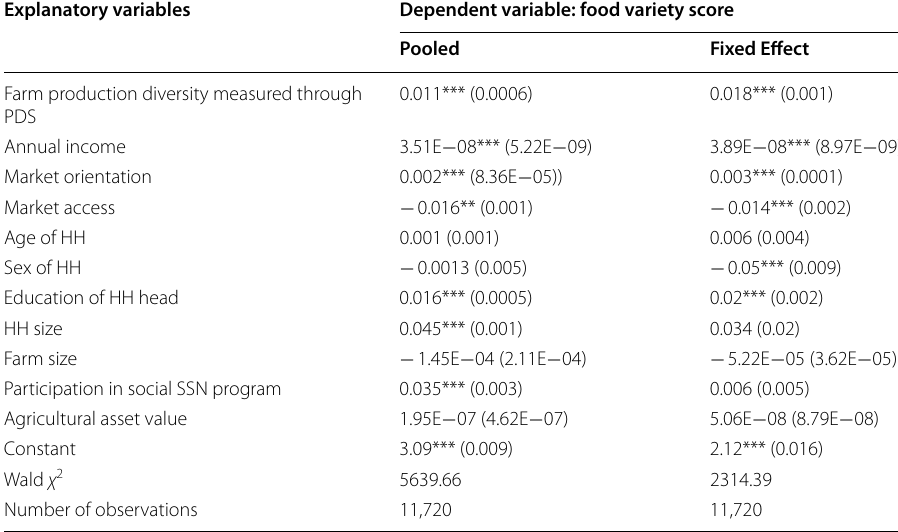
Authors’ analyses using 3 rounds of BIHS panel data ***, and ** indicate significance at the 1% and 5%, levels, respectively; figures in the parentheses are standard